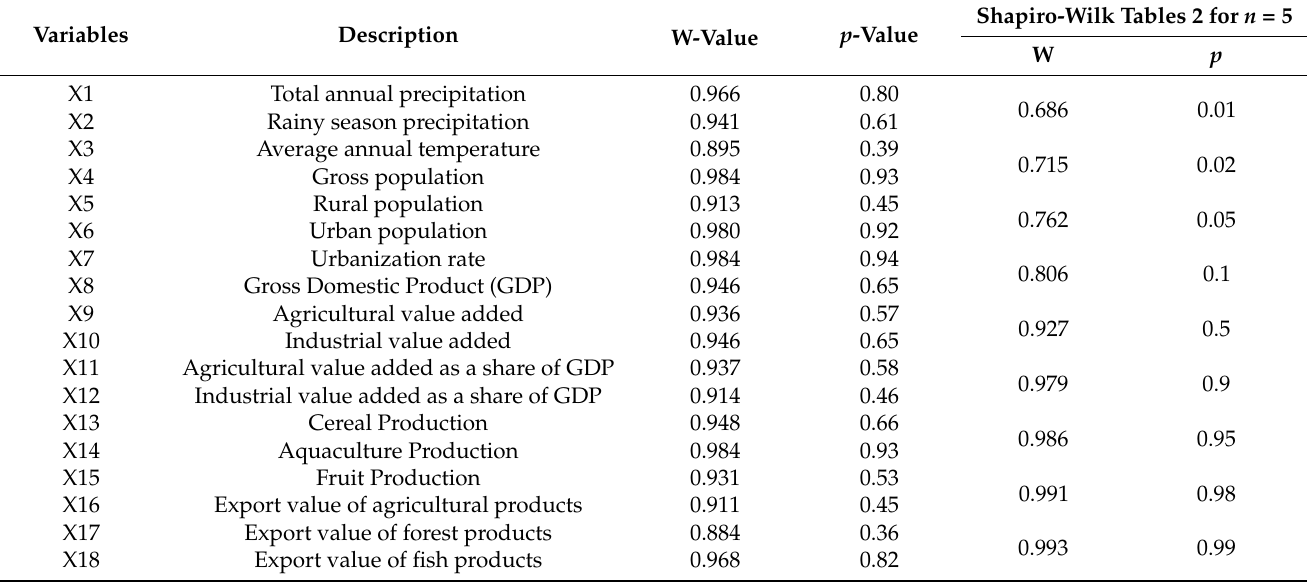
Table 3. Normality test of independent